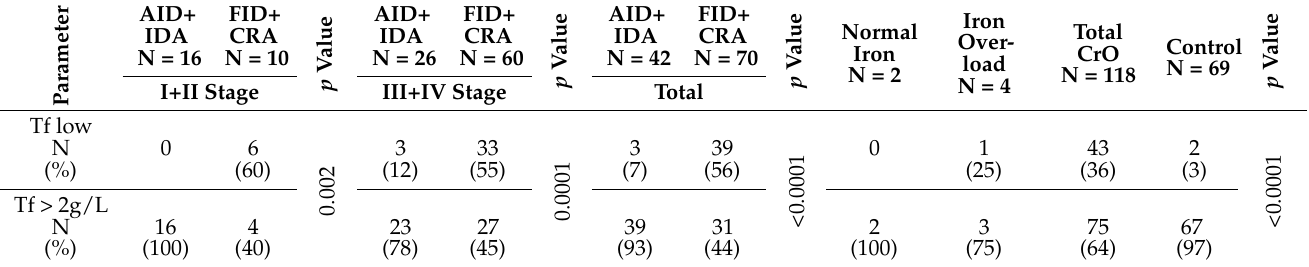
Table 3. The distribution of patients with a low transferrin (<2 g/L) concentration in ovarian cancer patients with different iron statuses and the control group.